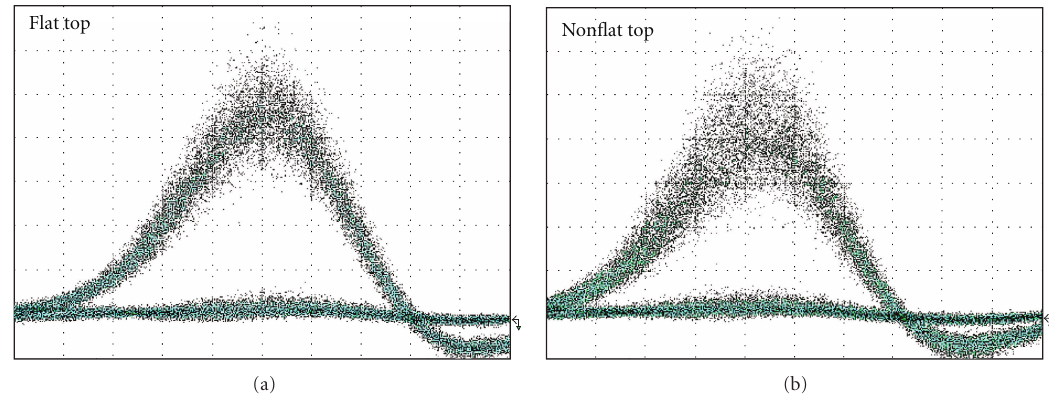
Figure 12: Eye diagrams obtained for flat-top and non-flat-top gating pulses.